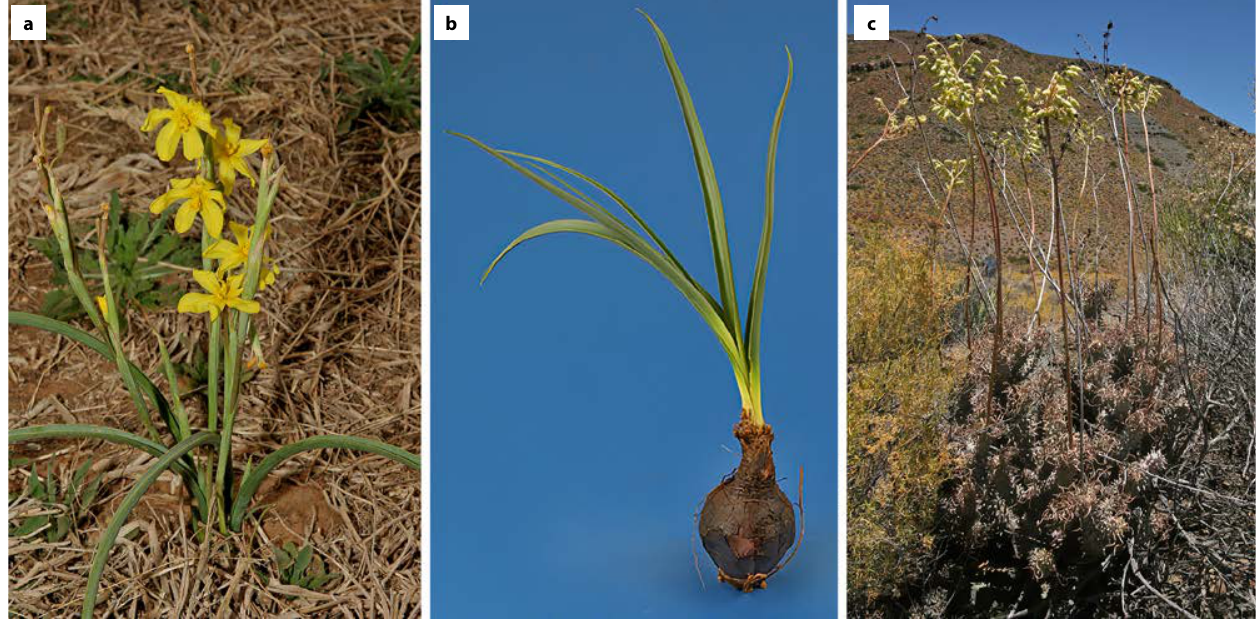
Figure 3: (a) Moraea pallida (= Homeria pallida ), (b) Drimia sanguinea (= Urginia sanguinea ) and (c) Tylecodon wallichii (= Cotyledon wallichii ) Photographs: A.E. van Wyk (a, c) & C.J. Botha